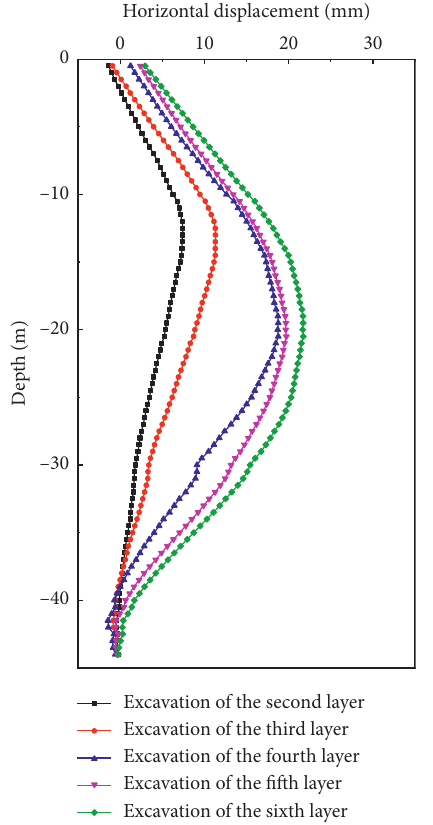
Figure 17: Change of the deep horizontal displacement of the enclosure wall at monitoring point ZQT15.